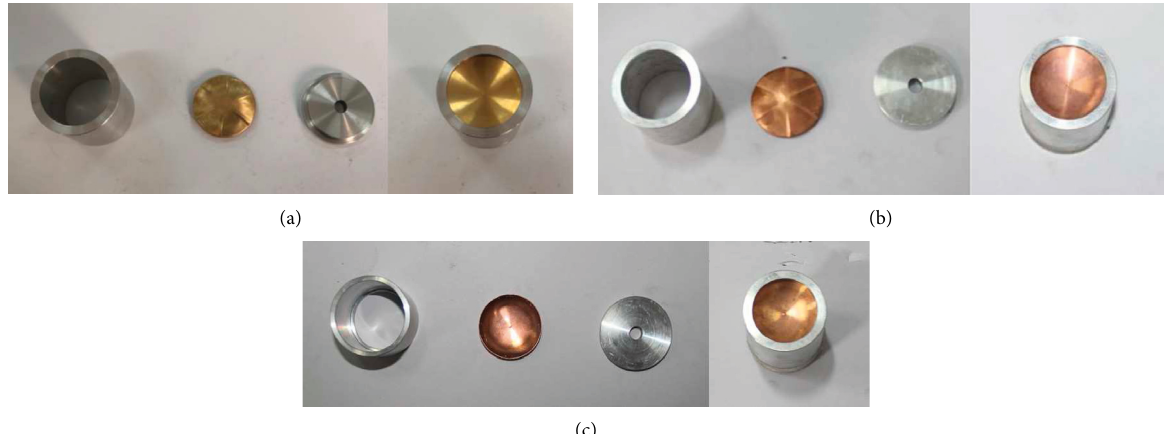
Figure 3: Photograph of the shaped charge: (a) H90 brass step-shaped charge, (b) T2 copper step-shaped charge, and (c) T2 copper-shaped charge with the constant wall